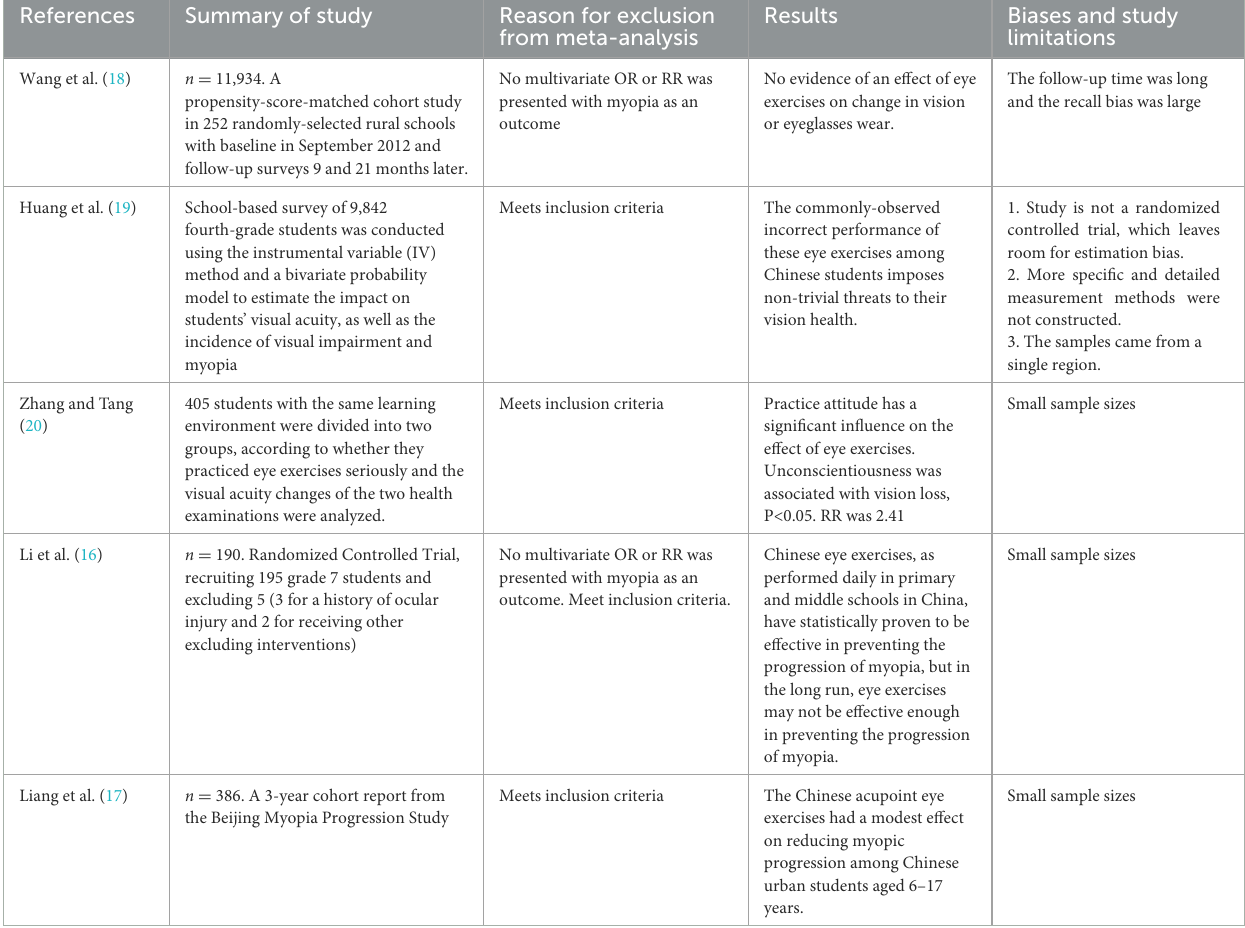
TABLE 2 Study on the relationship between eye exercises and